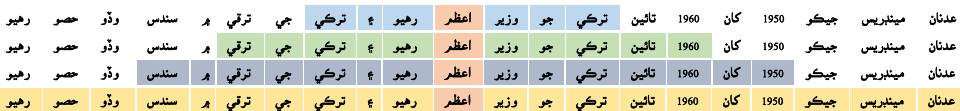
Figure 2. An example of a sentence taken from the SiNER dataset to select the context window size (CWS). The writing direction of Sindhi Persian-Arabic is